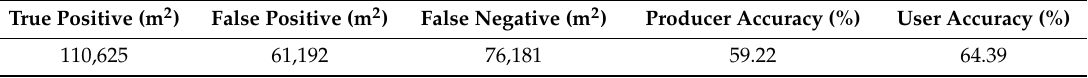
Table 2. Comparison of OBIA and manual landslides based on overlapping landslide area.